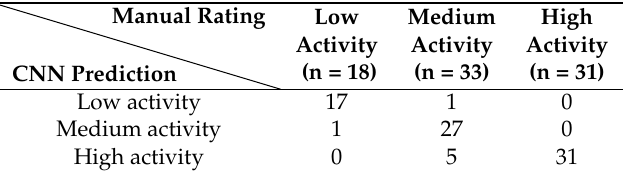
Table 1. Confusion matrix for the comparison between our method and manually evaluated videos. The entries on the main diagonal indicate the number of correctly classified sequences, whereas the entries above and below the main diagonal indicate predictions that deviate from the manual